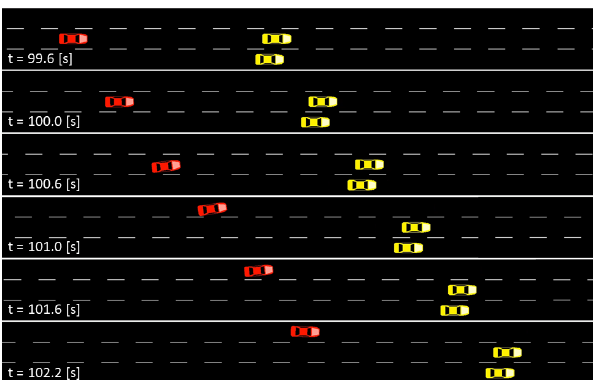
Figure 4. Visualization of the single lane changing scenario around t = 100